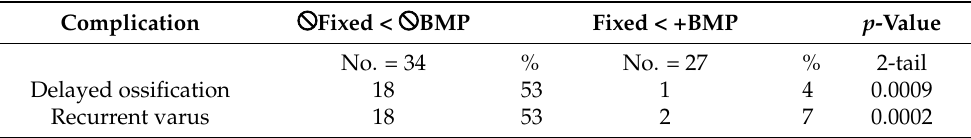
Table 4. Comparison of complications in primary SH: non-fixed angle + no BMP2 (group 1) vs. fixed angle + BMP2 (group 3). Table 5. Comparison of complications in revision SH: fixed angle + no BMP2 (group 2) vs. fixed angle + BMP (group 3).